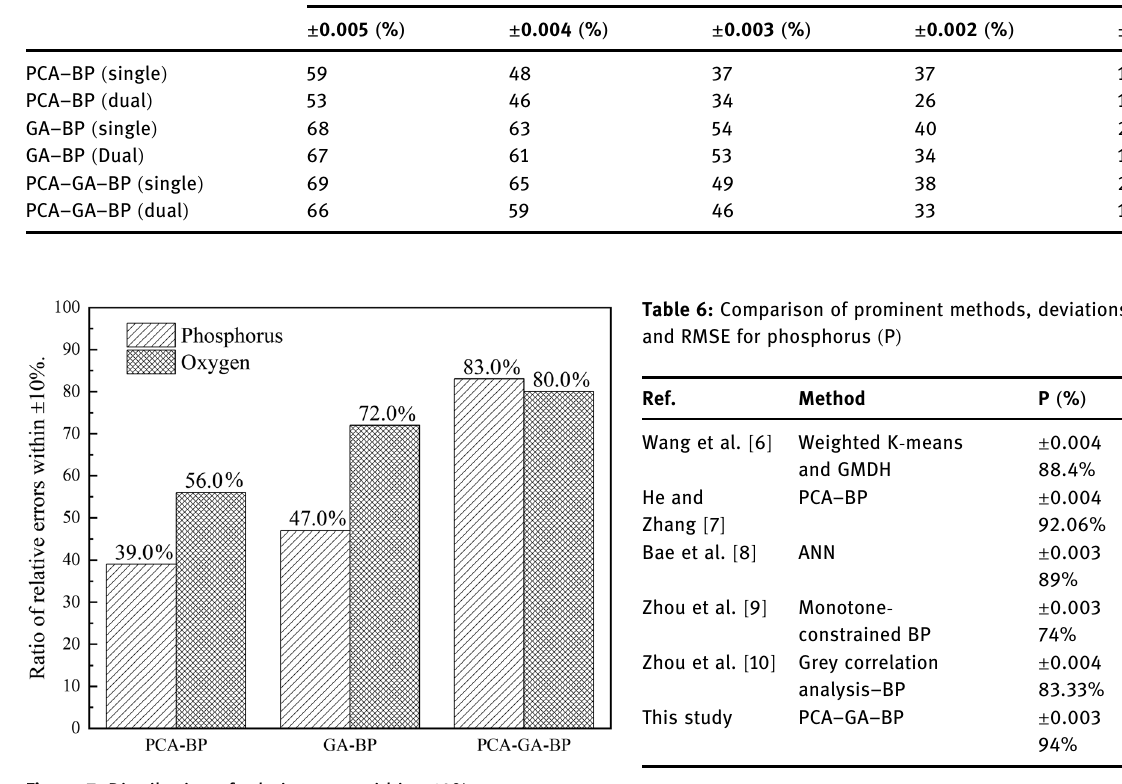
Figure 7: Distribution of relative error within ± 10%.